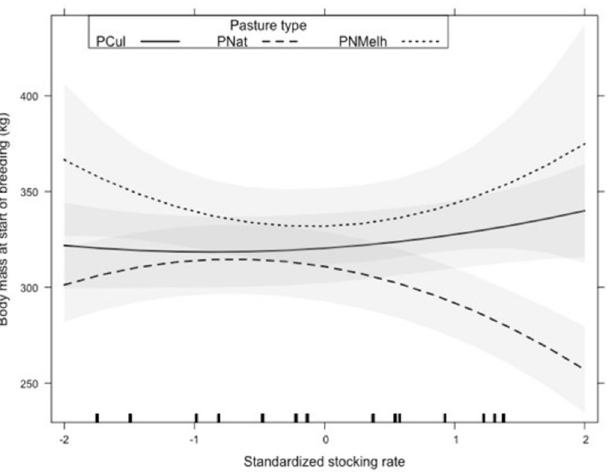
Fig 4. Effects of stocking rate and type of pasture on body weight at the beginning of the breeding season of heifers and primiparous cows. Pcul: cultivated pastures; PNMelh: improved pastures; PNat: native grasslands. P-value refer to the hypotheses that stocking rate has no effect on body weight at the start of the breeding season. Tick marks immediately above the X axis indicate the values of stocking rate present in the